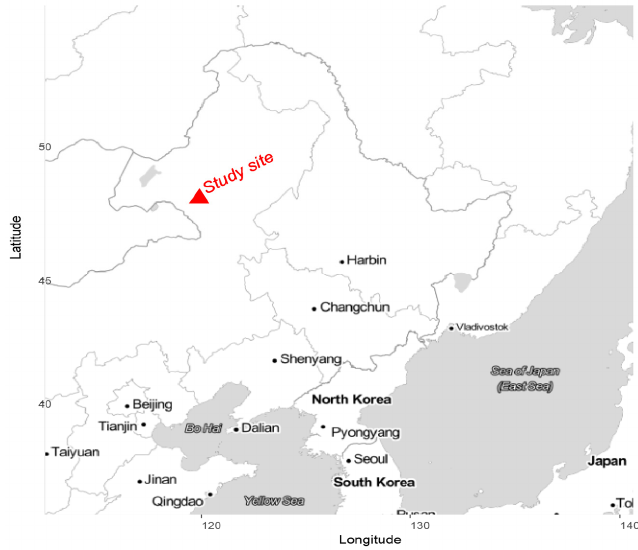
Figure 1. Map of study site. The map was produced using the Ggmap package in R software [42].